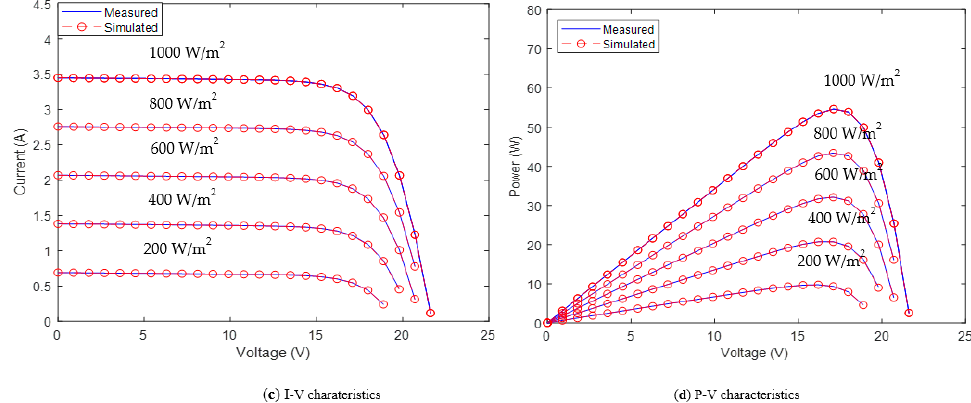
Figure 23. Depiction of the estimated and measured data obtained by MJSO on SM55 under different G with T = 25 °C.